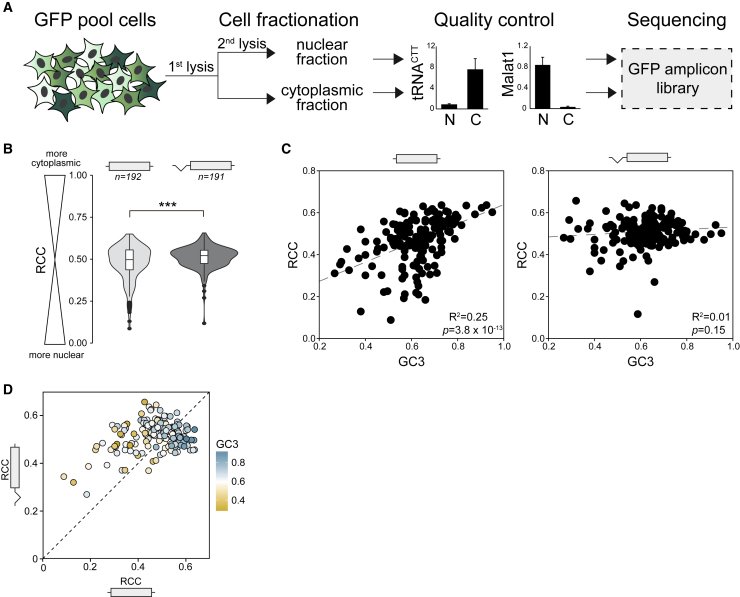
High GC Content Increases Cytoplasmic Localization of mRNA(A) Stable HeLa pools expressing 217 GFP variants ± intron were fractionated into nuclear and cytoplasmic portions before RNA extraction. Specific markers of subcellular compartments were quantified by qRT-PCR before amplicon library preparation.(B) RCC of unspliced and spliced GFP variants. Data represent the mean of 2 replicates. ∗∗∗p = 2 × 10−6.(C) Correlation between GC3 content and RCC for unspliced and spliced GFP RNA. Data points represent the means of 2 replicates.(D) Correlation between RCC scores of unspliced and spliced GFP (R2 = 0.1, p = 2.6 × 10−5).See also Figure S5.